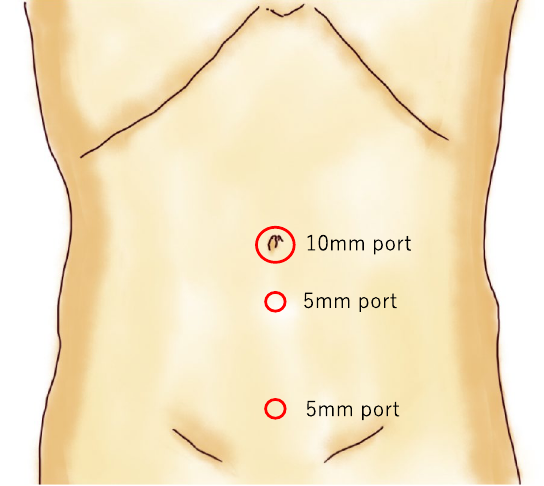
Fig. 5 Abdominal computed tomography revealed a 20 cystic mass in the right inguinal region